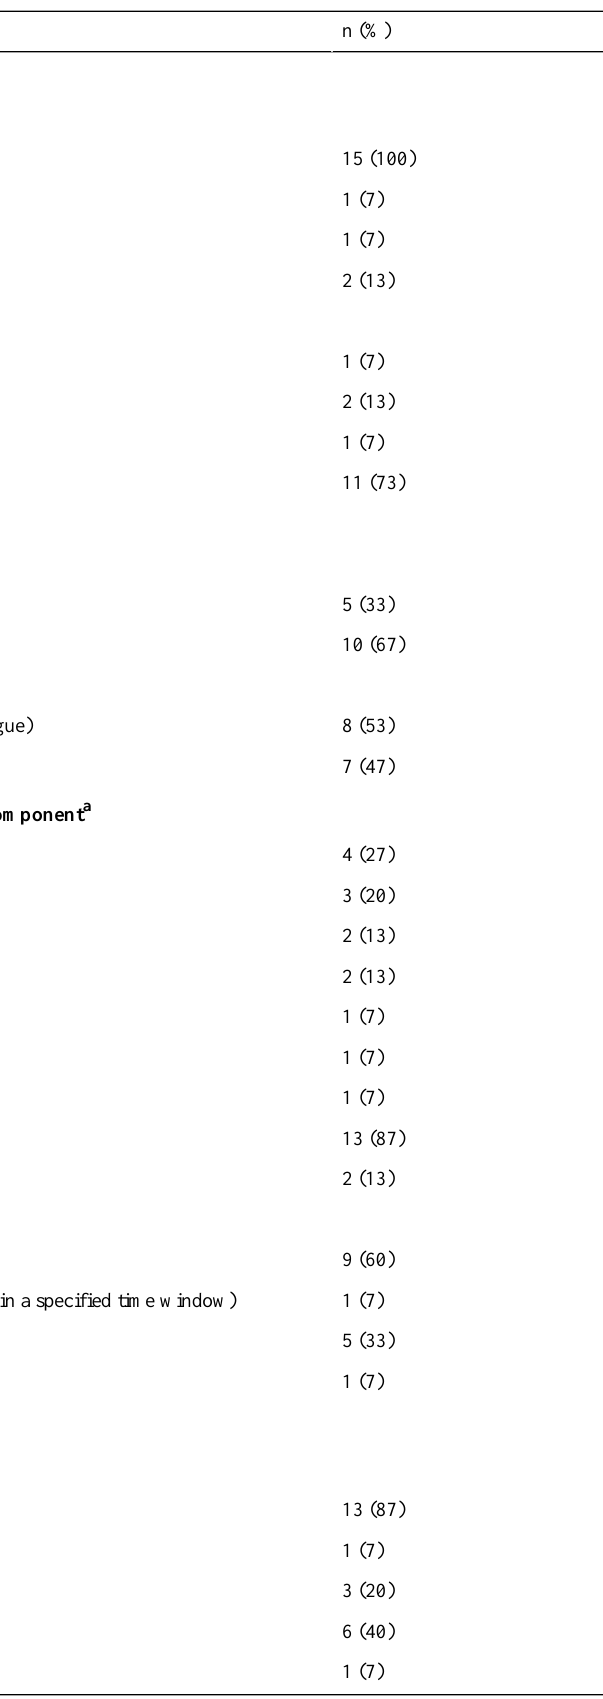
Table 3. Tool characteristics, intended use, and users (n=15). The table classifies variables according to unique tools rather than individual studies as the unit of